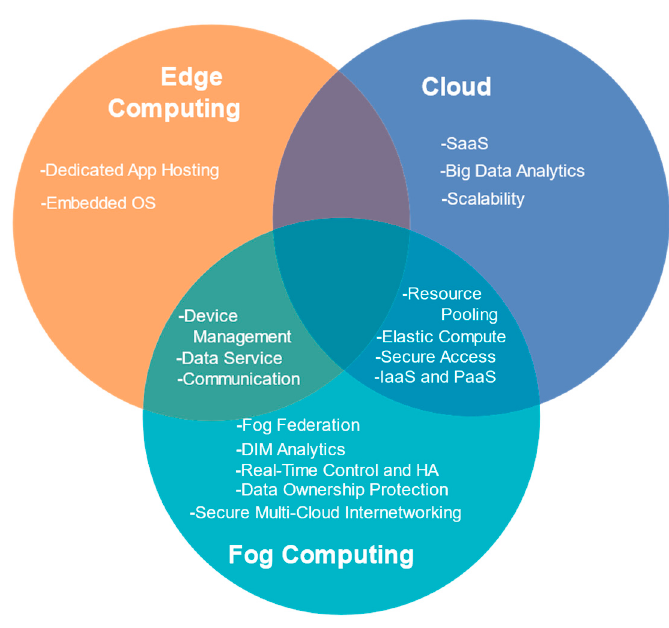
Figure 12. Cloud, fog, and edge computing alliance. Table 3. Comparison of fog, edge and cloud computing characteristics.